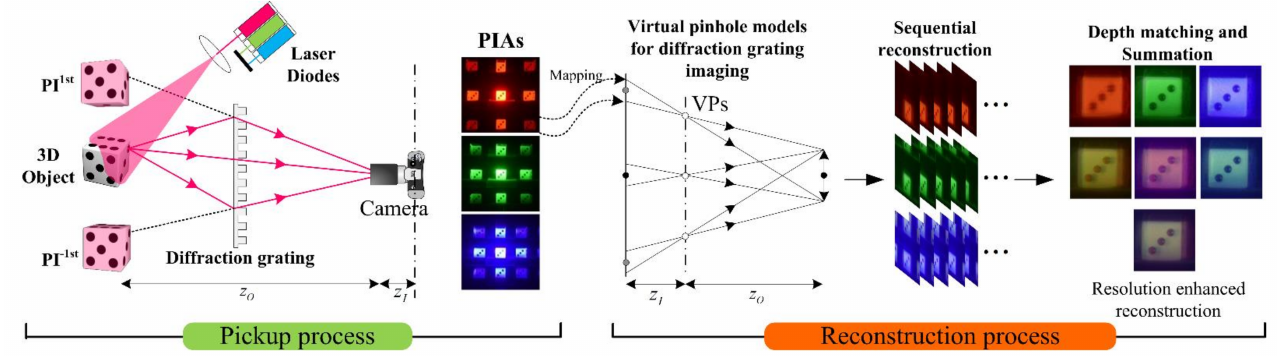
Figure 1. The proposed diffraction grating imaging system. It consists of a pickup process to acquire multiple PIAs from multiple wavelengths and a computational reconstruction process to generate 3-D